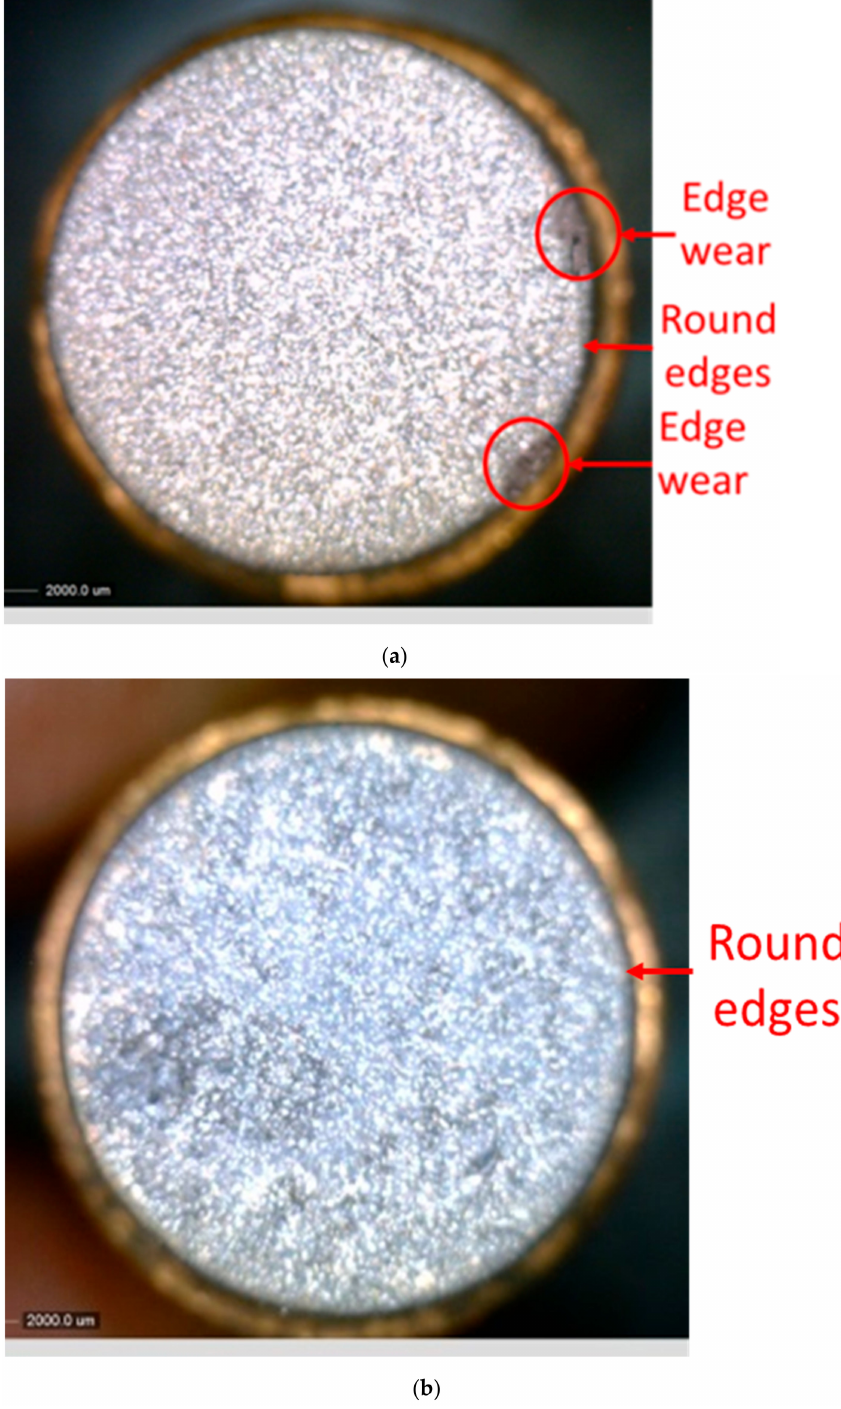
Figure 21. Variation in tool surface and profile with T on ( a ) T on = 300 µ s ( b ) T on = 450 µ s; other process parameters I p = 7 A, V g = 60 V, T off = 30 µ s, P= 16 kgf/cm 2